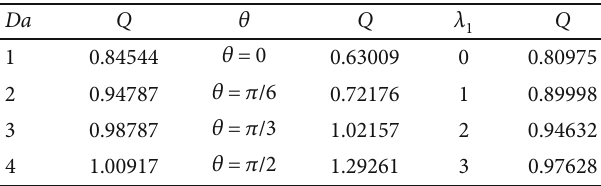
Table 2: Variation of volumetric fl ow rate with Darcy number ( Da ), angle of inclination ( θ ), and Je ff ery fl uid parameter ( λ 1 ).